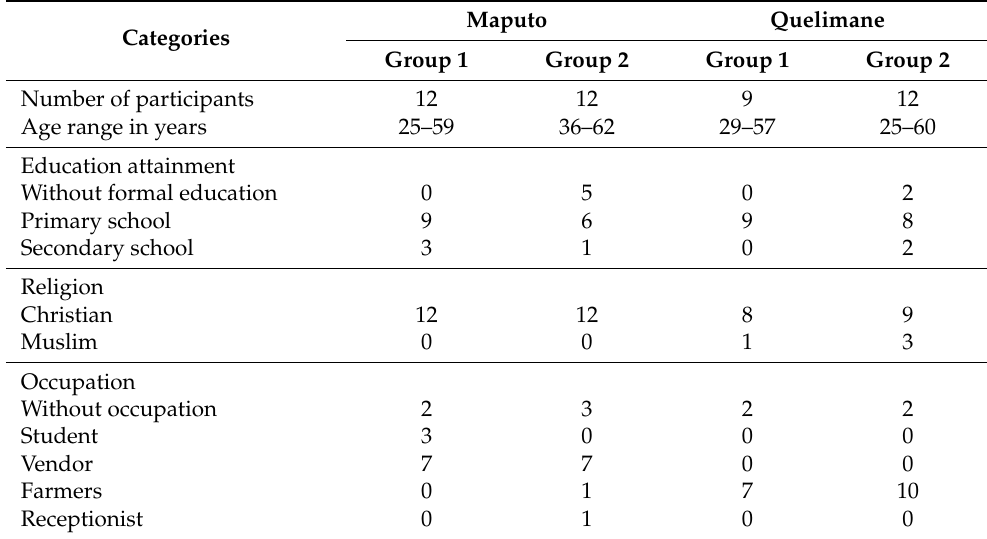
Table 1. Socio-demographic characteristics of the focus group